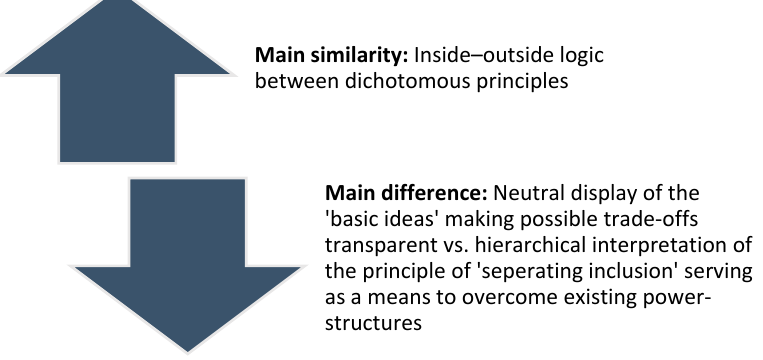
Figure 2. Comparison of the major similarity and difference between the basic ideas and the principle of separating inclusion (own illustration).